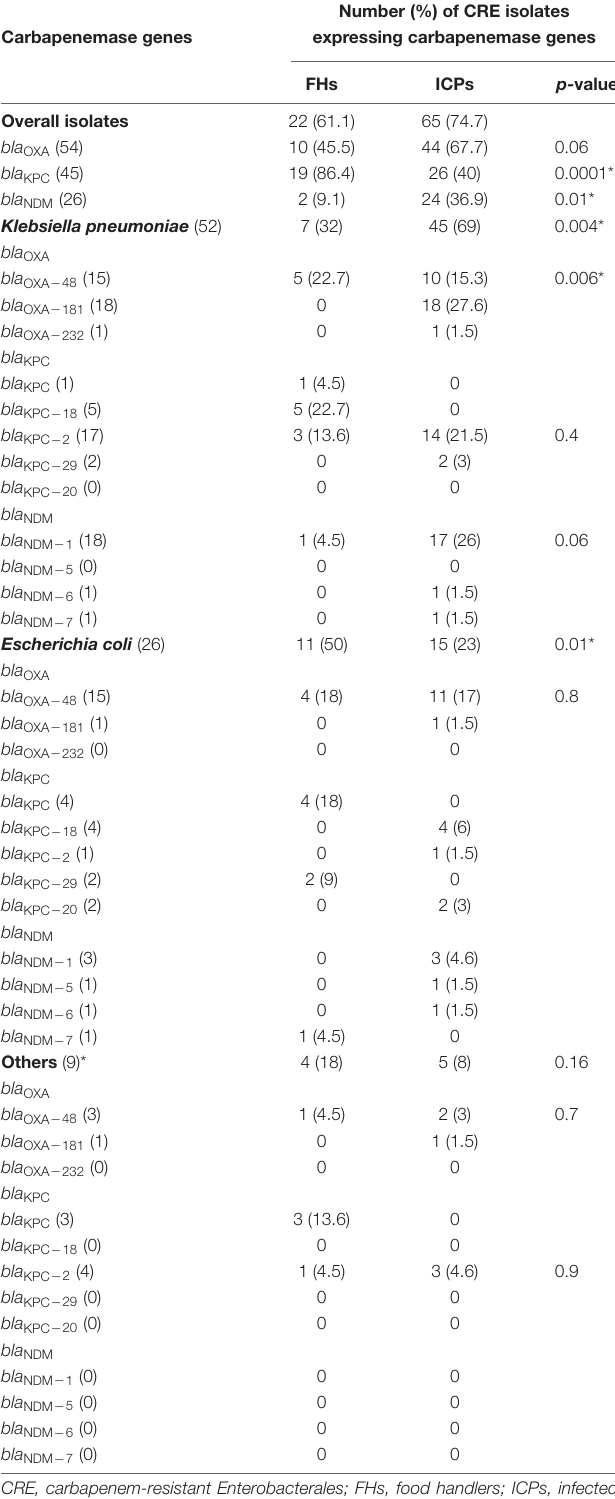
TABLE 4 | Proportion of CRE isolates expressing carbapenemase gene variants among food handlers and infected control patients. Number (%) of CRE